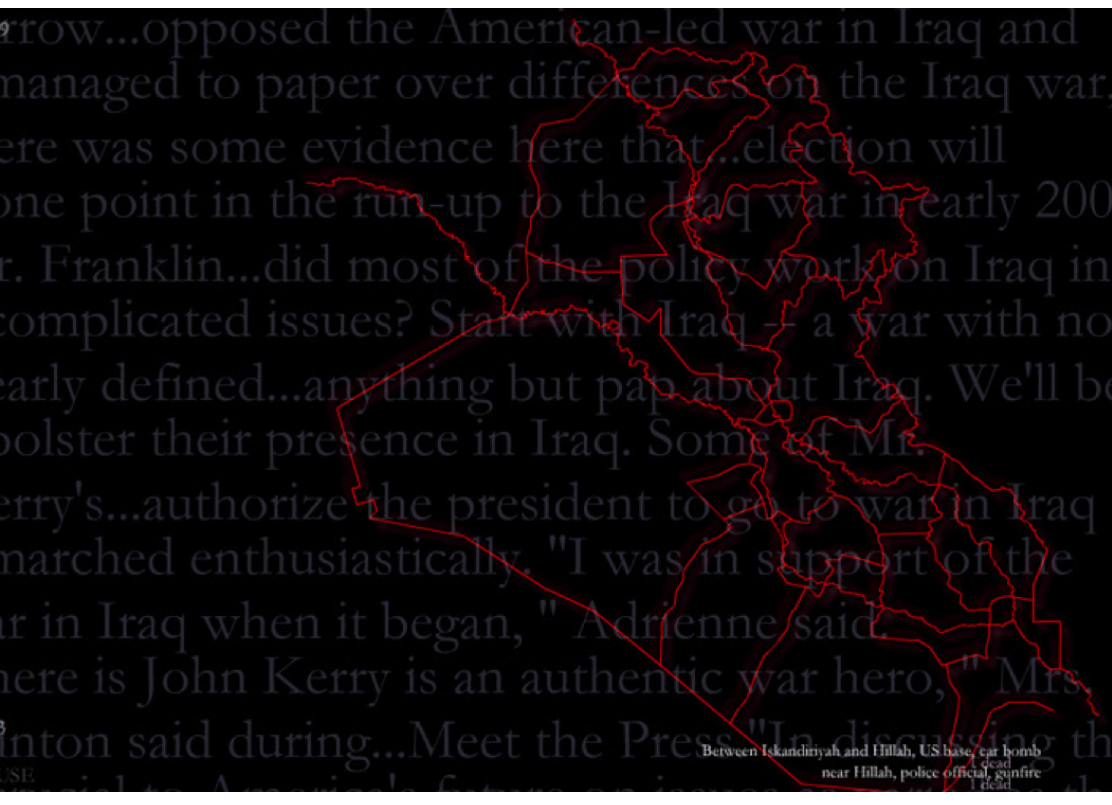
FIGURE 1 | R. Luke DuBois, Hard Data (2009). Online, open-source artwork. Computer loaded with kioskware, screen display, speakers. Courtesy R. Luke DuBois and bitforms gallery, New